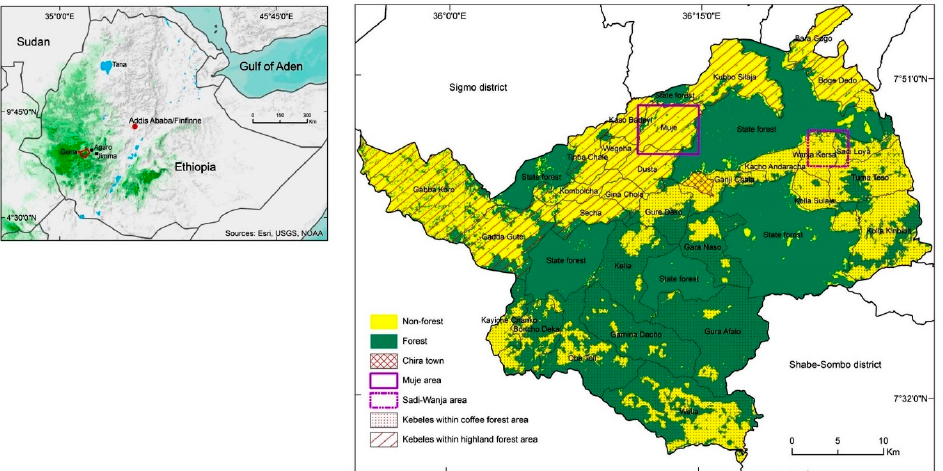
Figure 1. Map of Gera and names of kebeles within coffee and highland forest areas, and state forest blocks. The land cover (situation for 2010) of the district was produced from a free Landsat image (http://glovis.usgs.gov). Tree cover of the upper map represents the situation for 2000 (Hansen/UMD/Google/USGS/NASA).